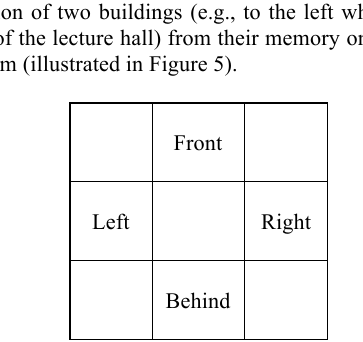
Figure 5. The diagram for marking the directions for Tasks 3, 5 and 6. Each zone corresponds to an area of approximately 45 o